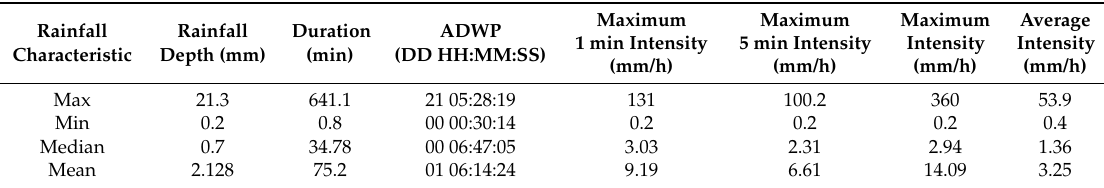
Table 1. Statistics of the 286 recorded storm